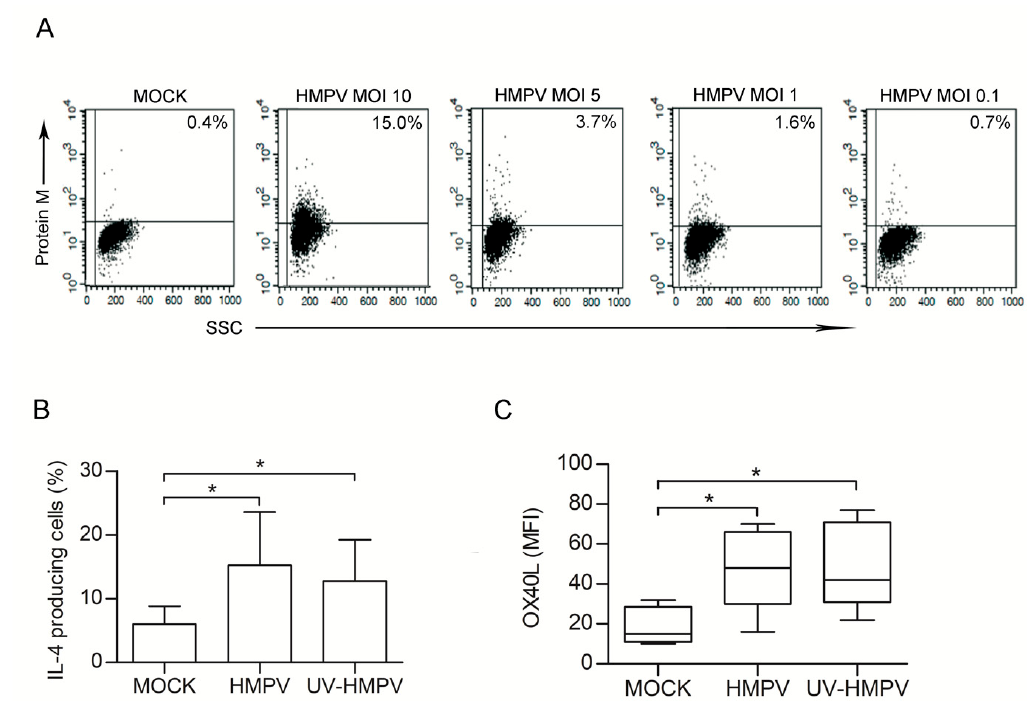
Figure 6. HMPV is capable, per se , to skew DCs toward a pro-Th2 phenotype. ( A ) DCs were left untreated or infected with HMPV at di ff erent MOIs (10, 5, 1, 0.1). After 48 h cells analysed by flow cytometry for the intracellular expression of the viral M protein. Dot plots show the fluorescence values vs the side scatter. Numbers in the upper right corner represent the % of cells expressing HMPV. Results are from one representative experiment out of 4 performed. ( B ) DCs were left untreated (MOCK) or treated for 48 h with UV-inactivated (UV-HMPV) or infectious (HMPV) HMPV at MOI 1. Allogenic coculture of DCs with naïve T cells was then performed and infectious IL-4 expression was evaluated as in Figure 3. Bars represent the mean ± SEM of IL-4-producing cells (%) detected upon the described culture conditions. Results are from one representative experiment out of four performed. * p < 0.05 ( C ) OX40L expression on DCs surface was evaluated upon 48 h of treatment with medium (MOCK) UV-inactivated (UV-HMPV) or infectious (HMPV) virus at MOI 1. Box-plots show the MFI values of OX40L expression detected in eight independent experiments. Lower quartile, median, upper quartile, and largest observations are represented. * p < 0.05.